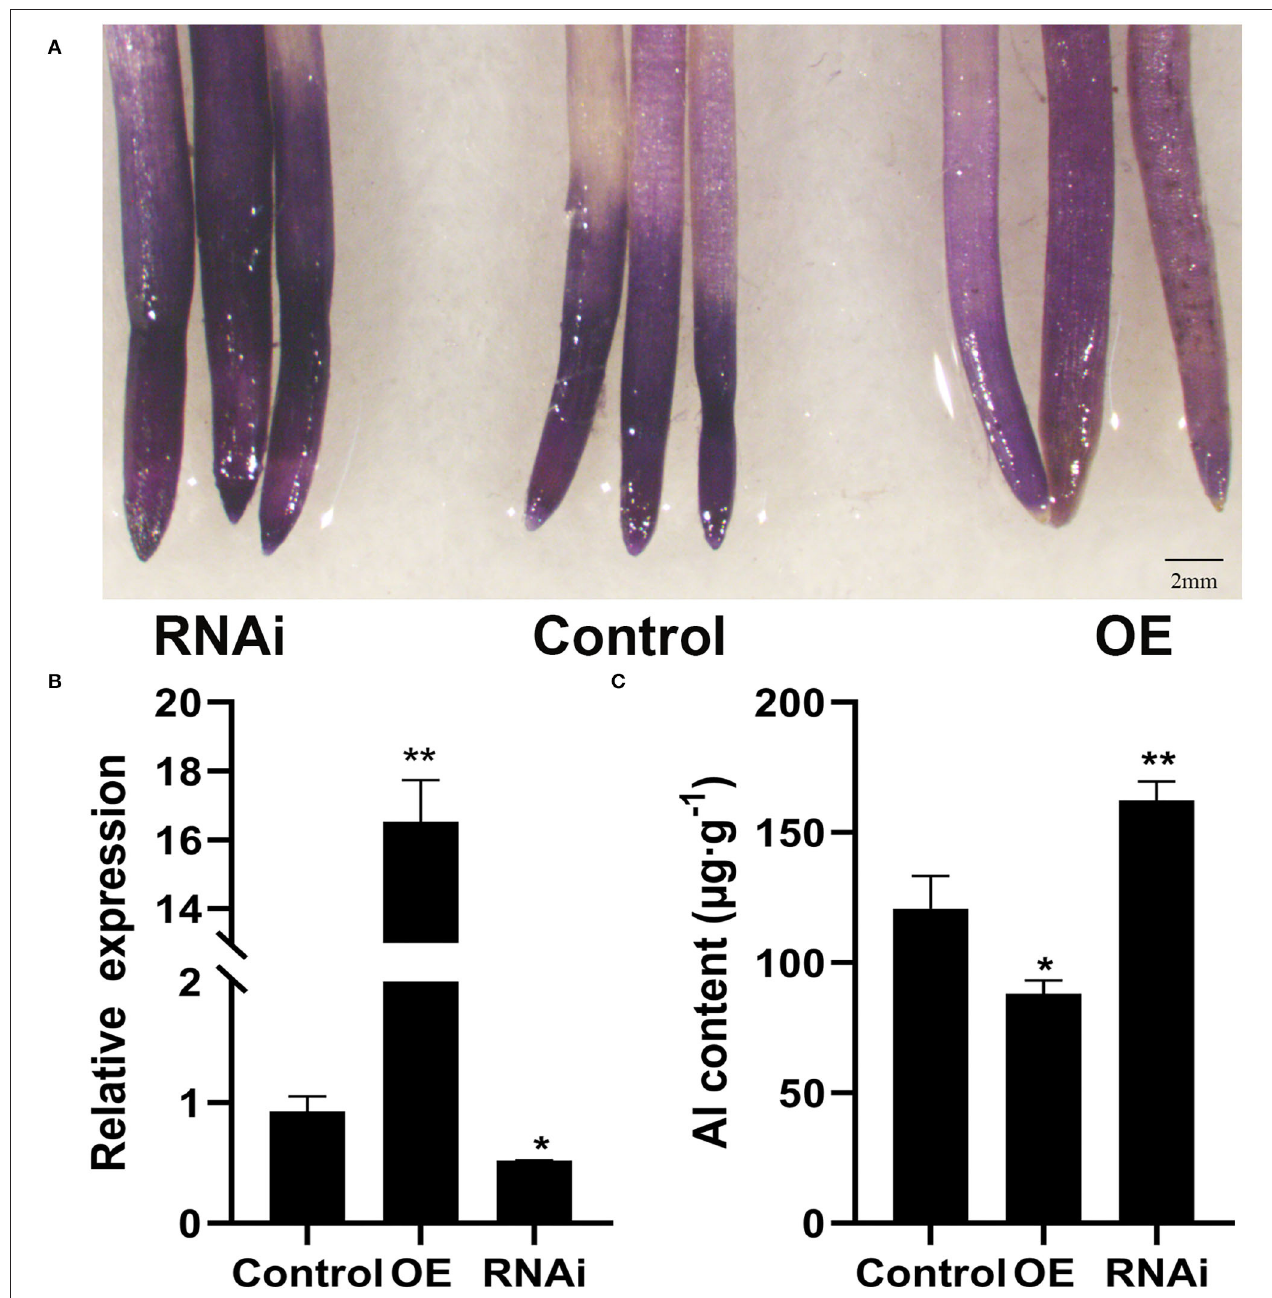
FIGURE 5 | Hematoxylin staining in soybean hairy roots. (A) Hematoxylin staining in soybean hairy roots. (B) Detection of RNA level in soybean hairy roots. (C) Determination of Al 3 + content in root tips. OE: the hairy roots of GmWRKY21 -overexpressing transgenic soybean; RNAi: the hairy roots of GmWRKY21 -RNAi transgenic soybean; Control: the hairy roots of Agrobacterium rhizogenes pathogenic strain K599 in soybean. The experiments were performed with at least three independent biological replicates. Significant differences according to the one-way analysis of variance are denoted as follows: * P < 0.05 and ** P <